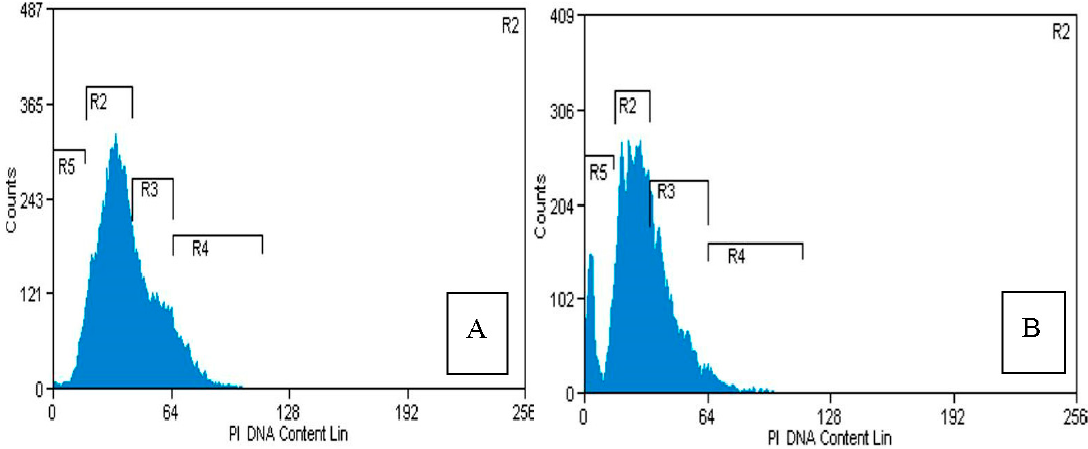
Figure 5. Cell cycle analysis of MCF-7 cells. ( A ) Control cells; ( B ) treated with 25 µg/mL PVLH-EAE for 48 h (R5: Sub G1, R2: G1, R3: S, R4: G2/M).